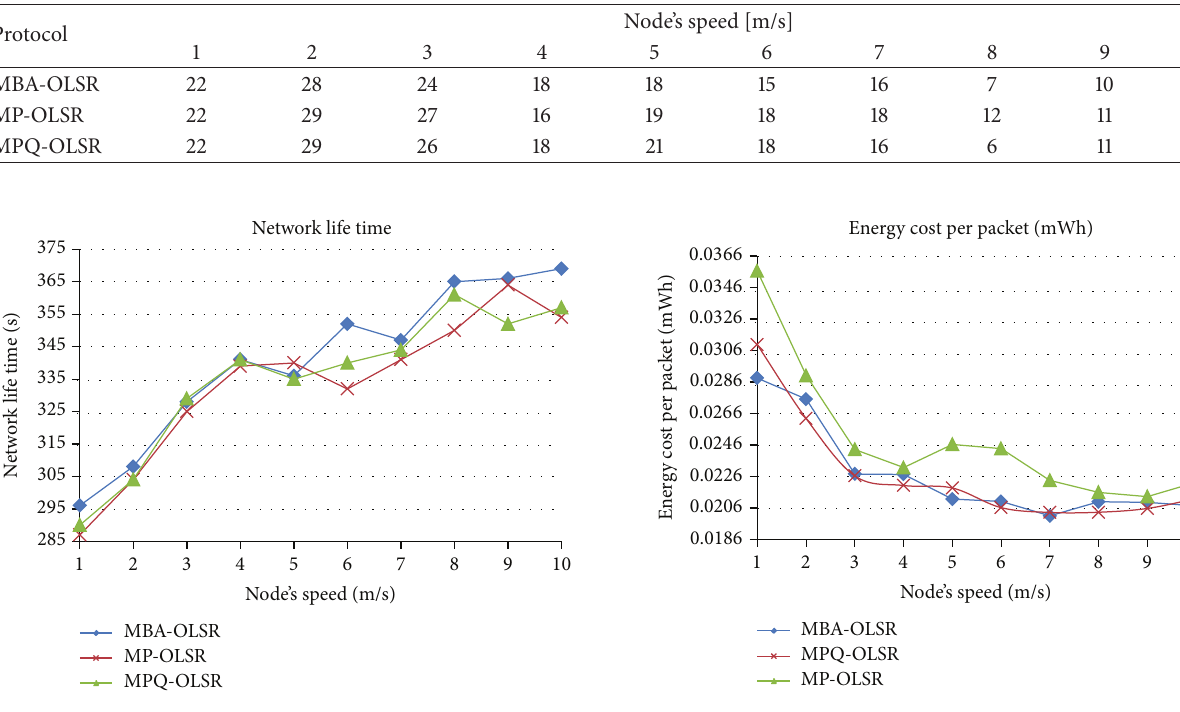
time scenarios in terms of network lifetime and QoS